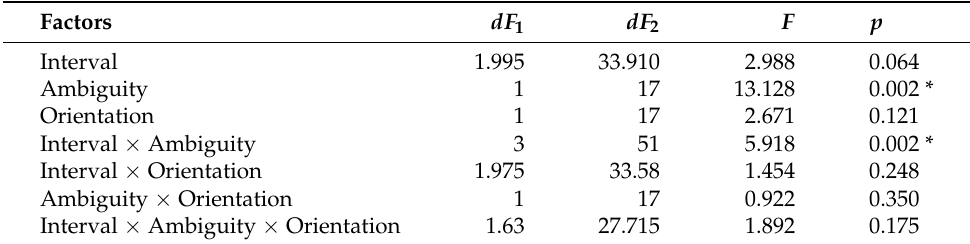
Table 2. Percentage of erroneous responses to the current stimulus, ER [%] (ANOVA